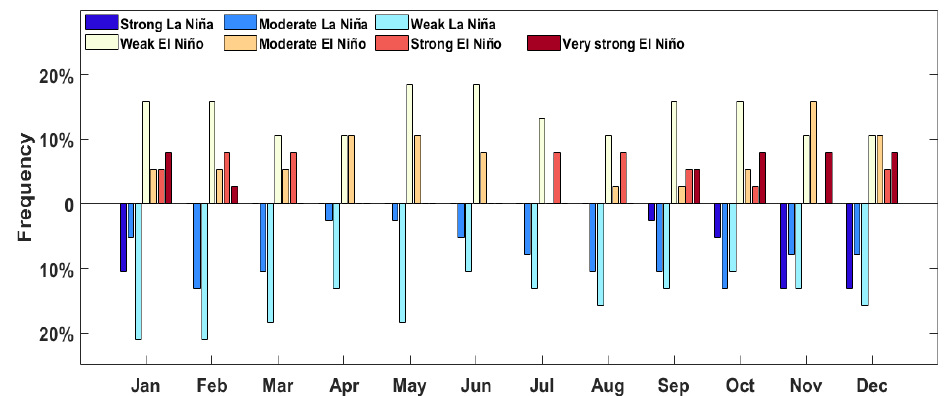
Figure 11. The ENSO event frequency between 1979 and 2016.